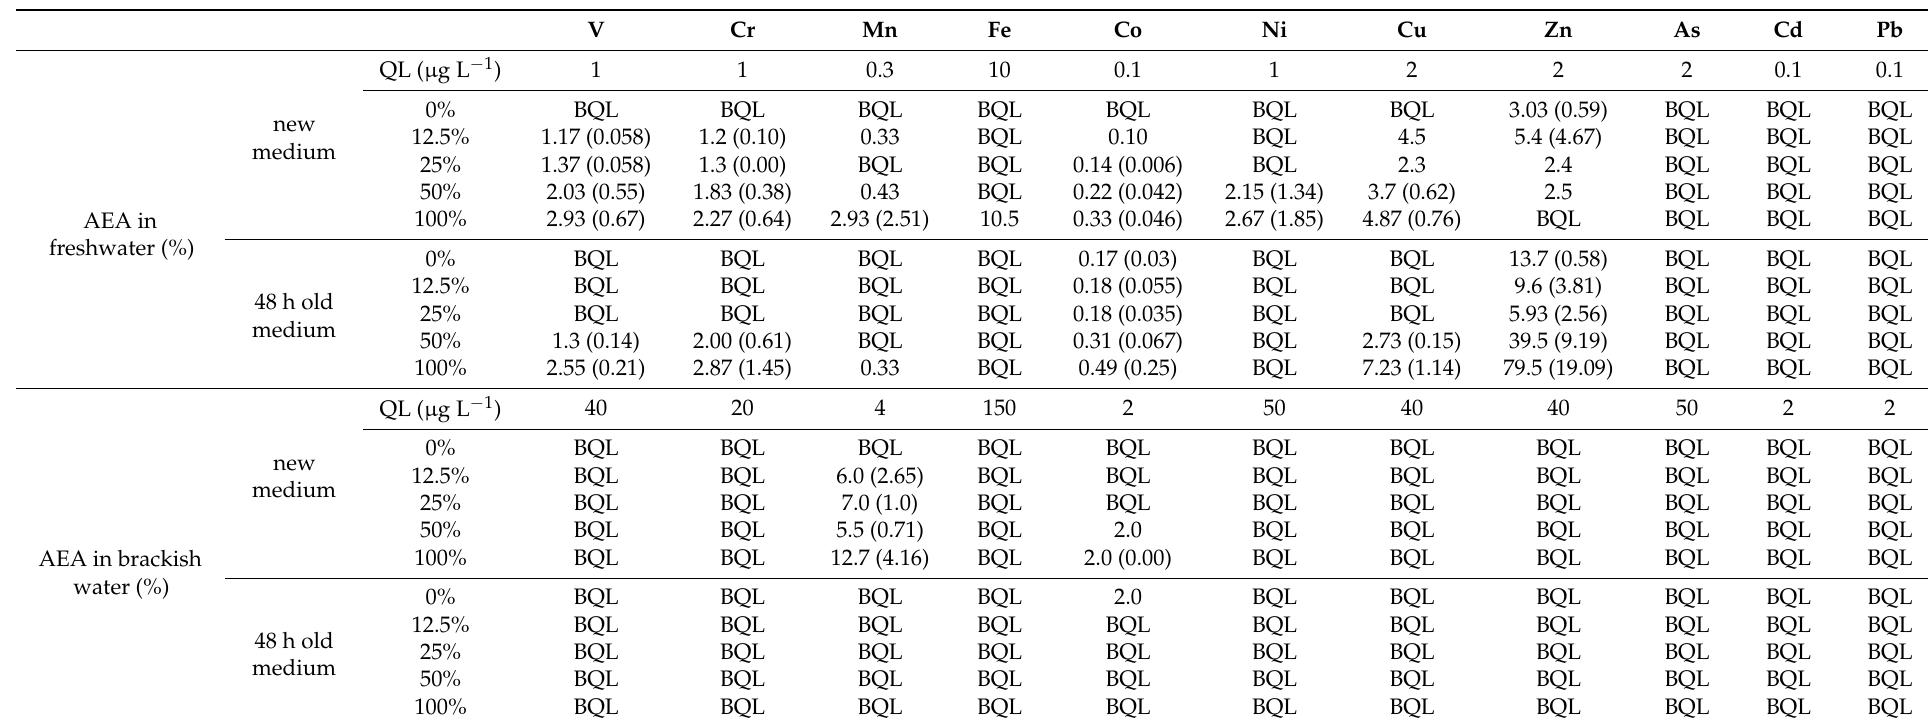
Table 1. Average metal concentrations ( µ g L − 1 ) in the test media (freshwater and brackish water, respectively for C. fluminea and C. edule ), immediately after preparation (new medium) and after a 48 h exposure period (48 h old medium) at different aqueous extracts of ash (AEAs) concentrations (0, 12.5, 25, 50, and 100%). The quantification limit (QL) of the different elements for each medium is also presented. BQL—below quantification limit. Standard deviation is presented within